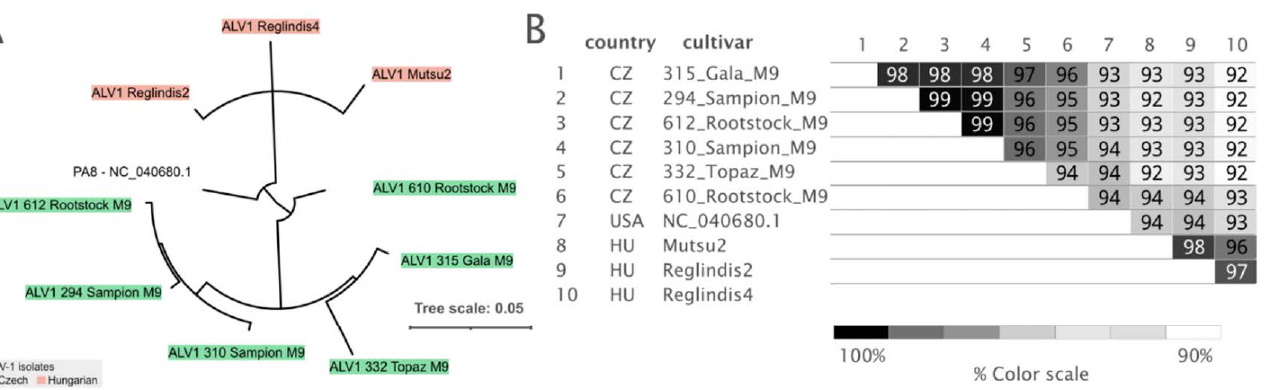
Figure 6. ( A ) Phylogeny of nearly complete genomes of ALV-1. All branches with support less than 0.8 were collapsed. ( B ) Nucleotide identity between the ALV-1